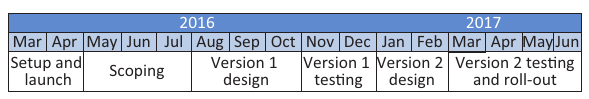
FIGURE 1: Timeline of the launch, development process and pilot